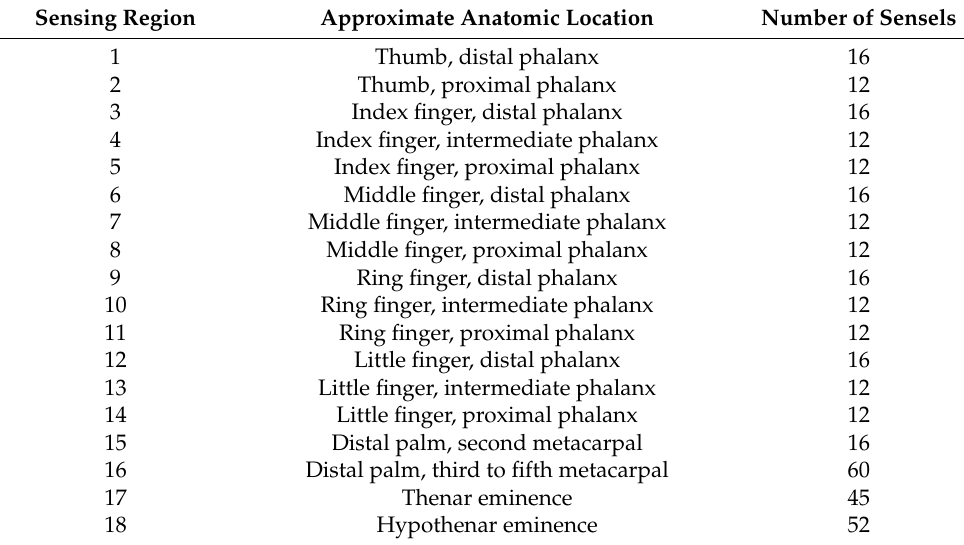
Figure 5. Sensor regions and their approximate locations in the hand palm. Table 3. Sensing regions of the sensor and corresponding anatomical locations.